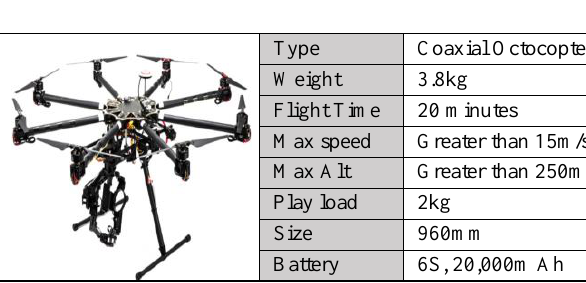
Table 3. Drone specification produced by KEVA DRONE